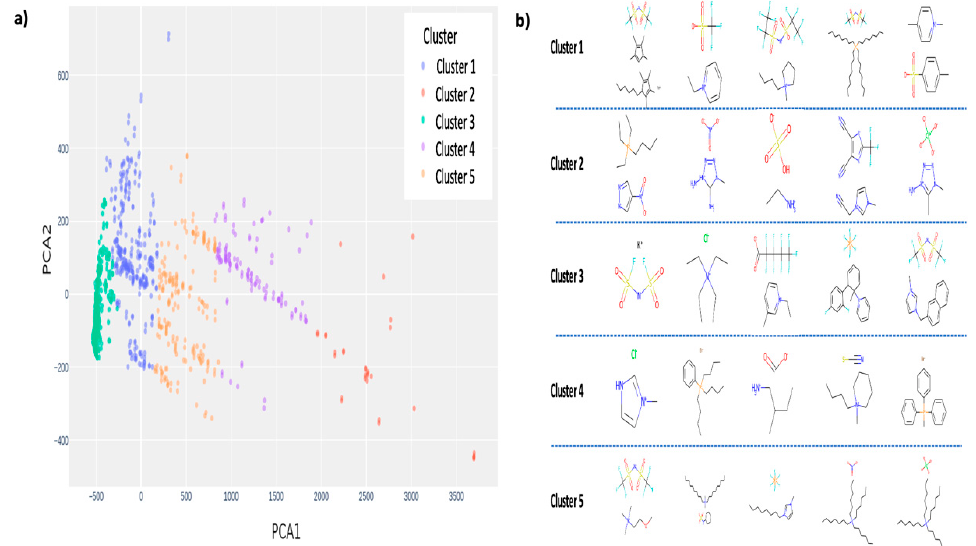
Figure 3. ( a ) The score plot for the first two principal components (PCA1, PCA2) with respect to 5 clusters that representing 1253 ILs dataset. ( b ) The randomly selected representative ILs molecules from cluster 1 to 5 dataset.